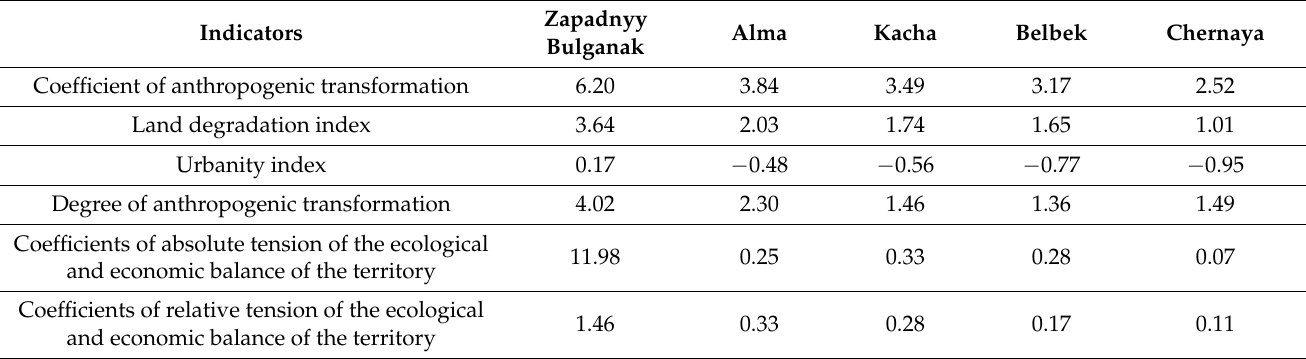
Table 1. Comparison of the values of indicators characterising the transformation of the river basins of the northwestern slope of the Crimean Mountains (Zapadnyy Bulganak, Alma, Kacha, Belbek, and Chernaya